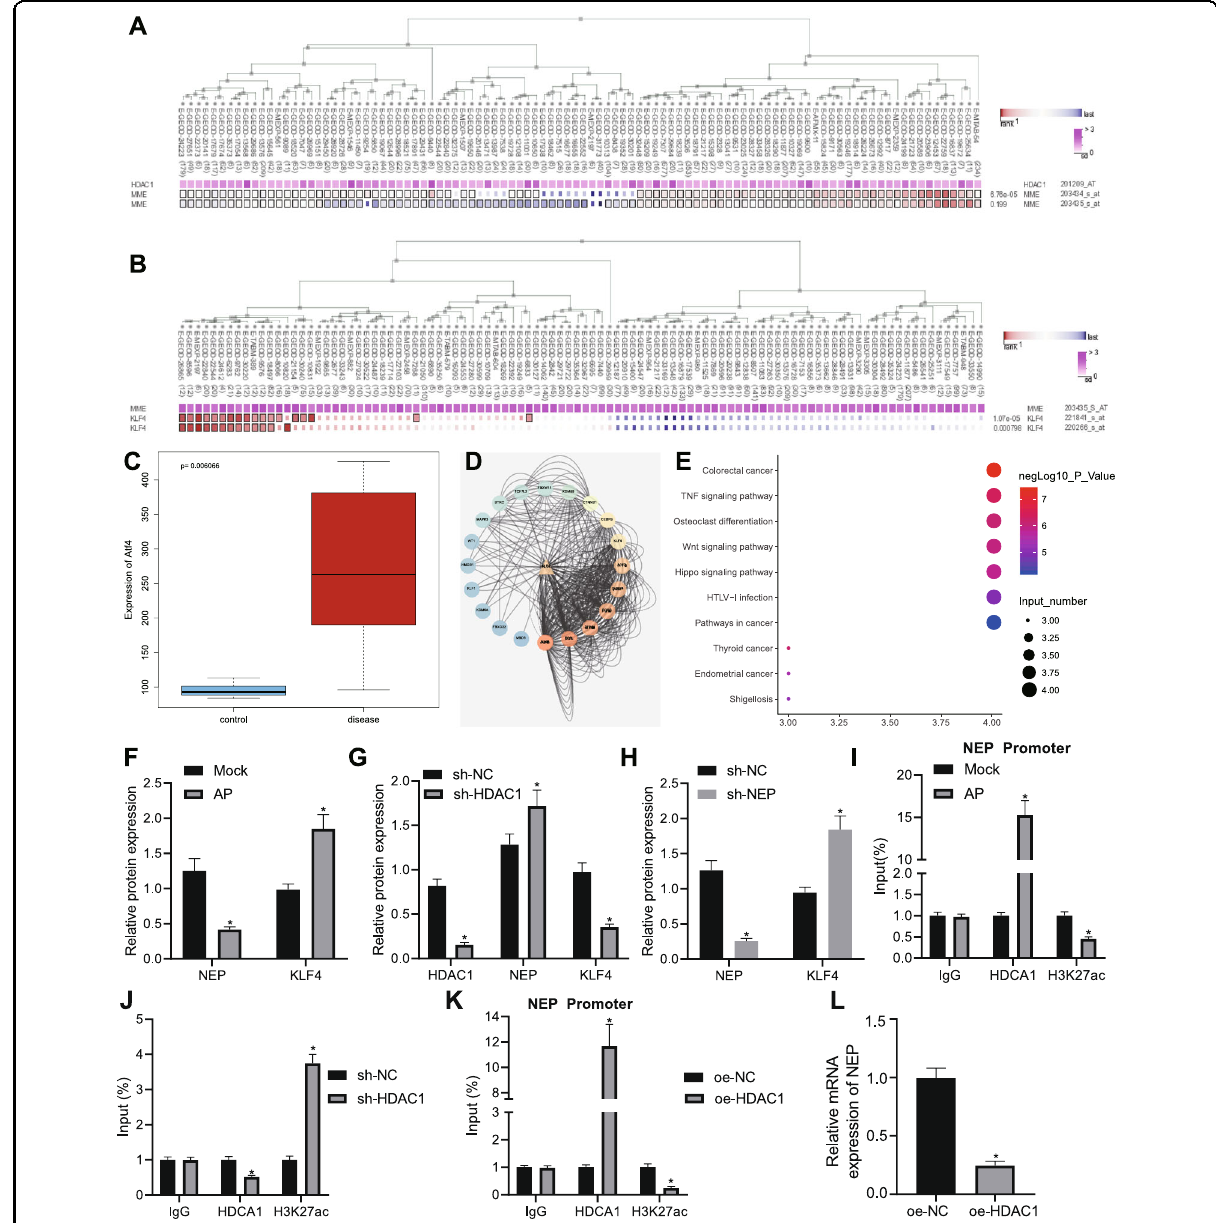
Fig. 5 HDAC1 promotes KLF4 expression by inhibiting NEP expression. A Co-expression analysis with MEM to determine the co-expression relationship between HDAC1 and NEP ( p = 6.76e − 05). B Co-expression analysis with MEM to determine the co-expression relationship between NEP and KLF4 ( p = 6.76e − 05). C A box plot from the expression data of the microarray dataset GSE3644 to determine expression of KLF4. The blue box on the left represents the expression of normal samples, and the red box on the right represents the expression of pancreatitis samples. D GeneMANIA predicted KLF4 related genes and constructed a PPI network diagram. The triangle gene in the middle is KLF4, and the outer circle gene is the predicted related gene. The redder the color of the gene, the higher the core degree, and vice versa the bluer the core, the lower the degree. E KOBAS was performed for KEGG enrichment analysis of KLF4 and its related genes. The vertical axis represents the enriched pathway. The horizontal axis and the size of the bubble represent the number of genes enriched on the pathway. Signi fi cance-log P value, the greater the signi fi cance, the redder the bubbles, and the smaller the signi fi cance, the bluer the bubbles. F Western blot analysis to detect the expression of NEP and KLF4 in AP. G Western blot analysis to detect the expression of HDAC1, NEP, and KLF4 in AP after silencing NEP. H Western blot analysis to detect the expression of NEP and KLF4 in AP. I ChIP detected the enrichment of HDAC1 and H3K27ac in the NEP promoter of each group. J ChIP detected the enrichment of HDAC1 and H3K27ac in the NEP promoter of each group after silencing NEP. K ChIP detected the enrichment of HDAC1 and H3K27ac in the NEP promoter of each group. L RT-qPCR detected HDAC1 mRNA expression. * p < 0.05 compared with the Mock, WT or sh-NC group. The comparison of the measurement data (mean standard ± deviation) between two groups were tested by independent sample t -test.